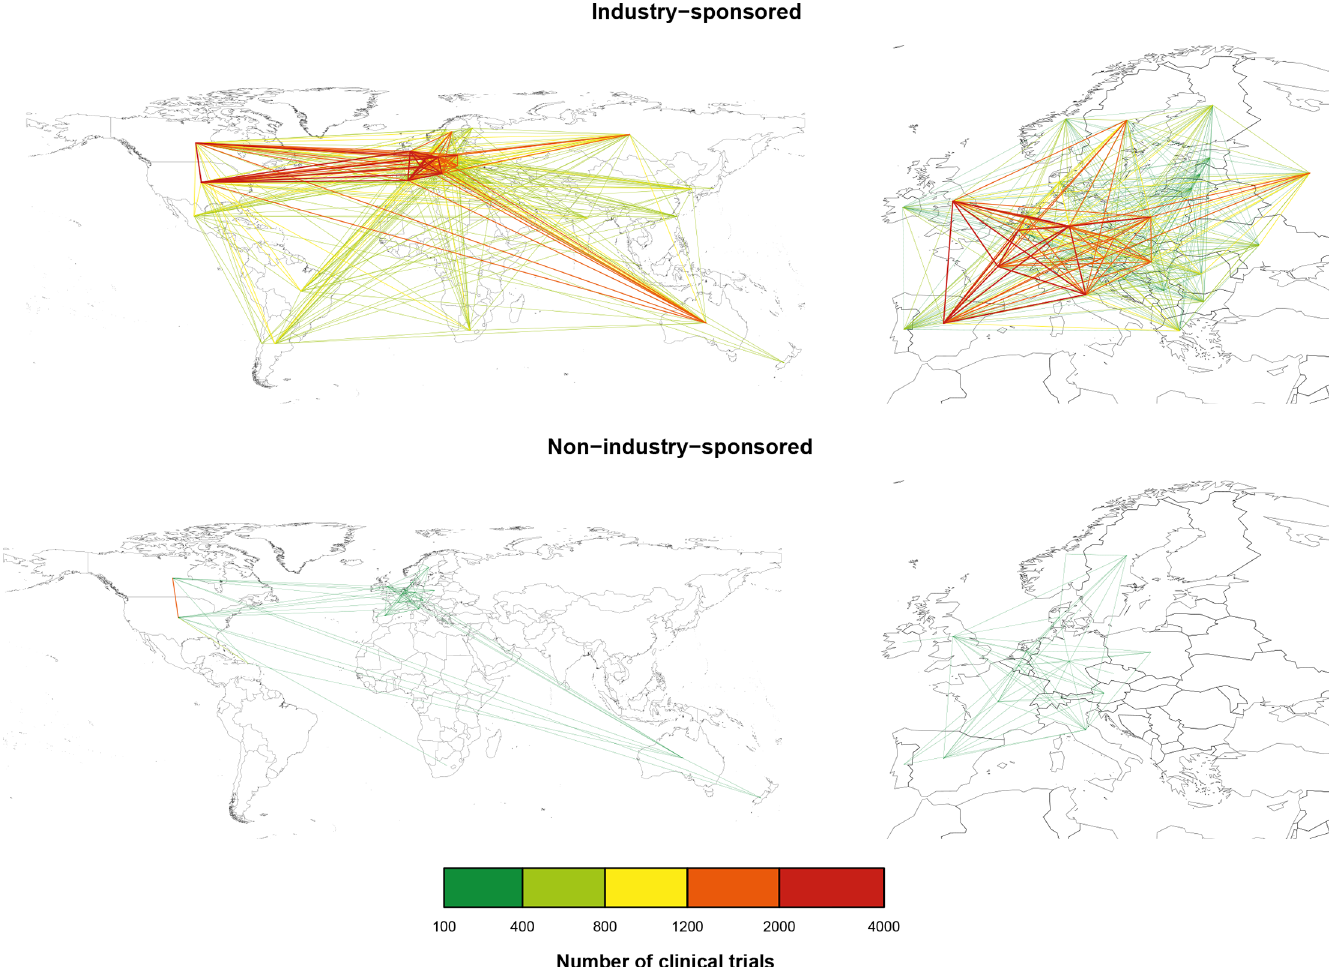
Fig 4. World and European collaboration networks in industry- and non-industry – sponsored clinical trials. Collaboration network of industry- (top) and non-industry – sponsored (bottom) clinical trials for registered trials initiated from 2006 to 2013; the color of a link between two countries corresponds to the number of clinical trials simultaneously conducted in both countries. For clarity, links between 100 and 400 clinical trials are not shown for the world ’ s industry-sponsored network.